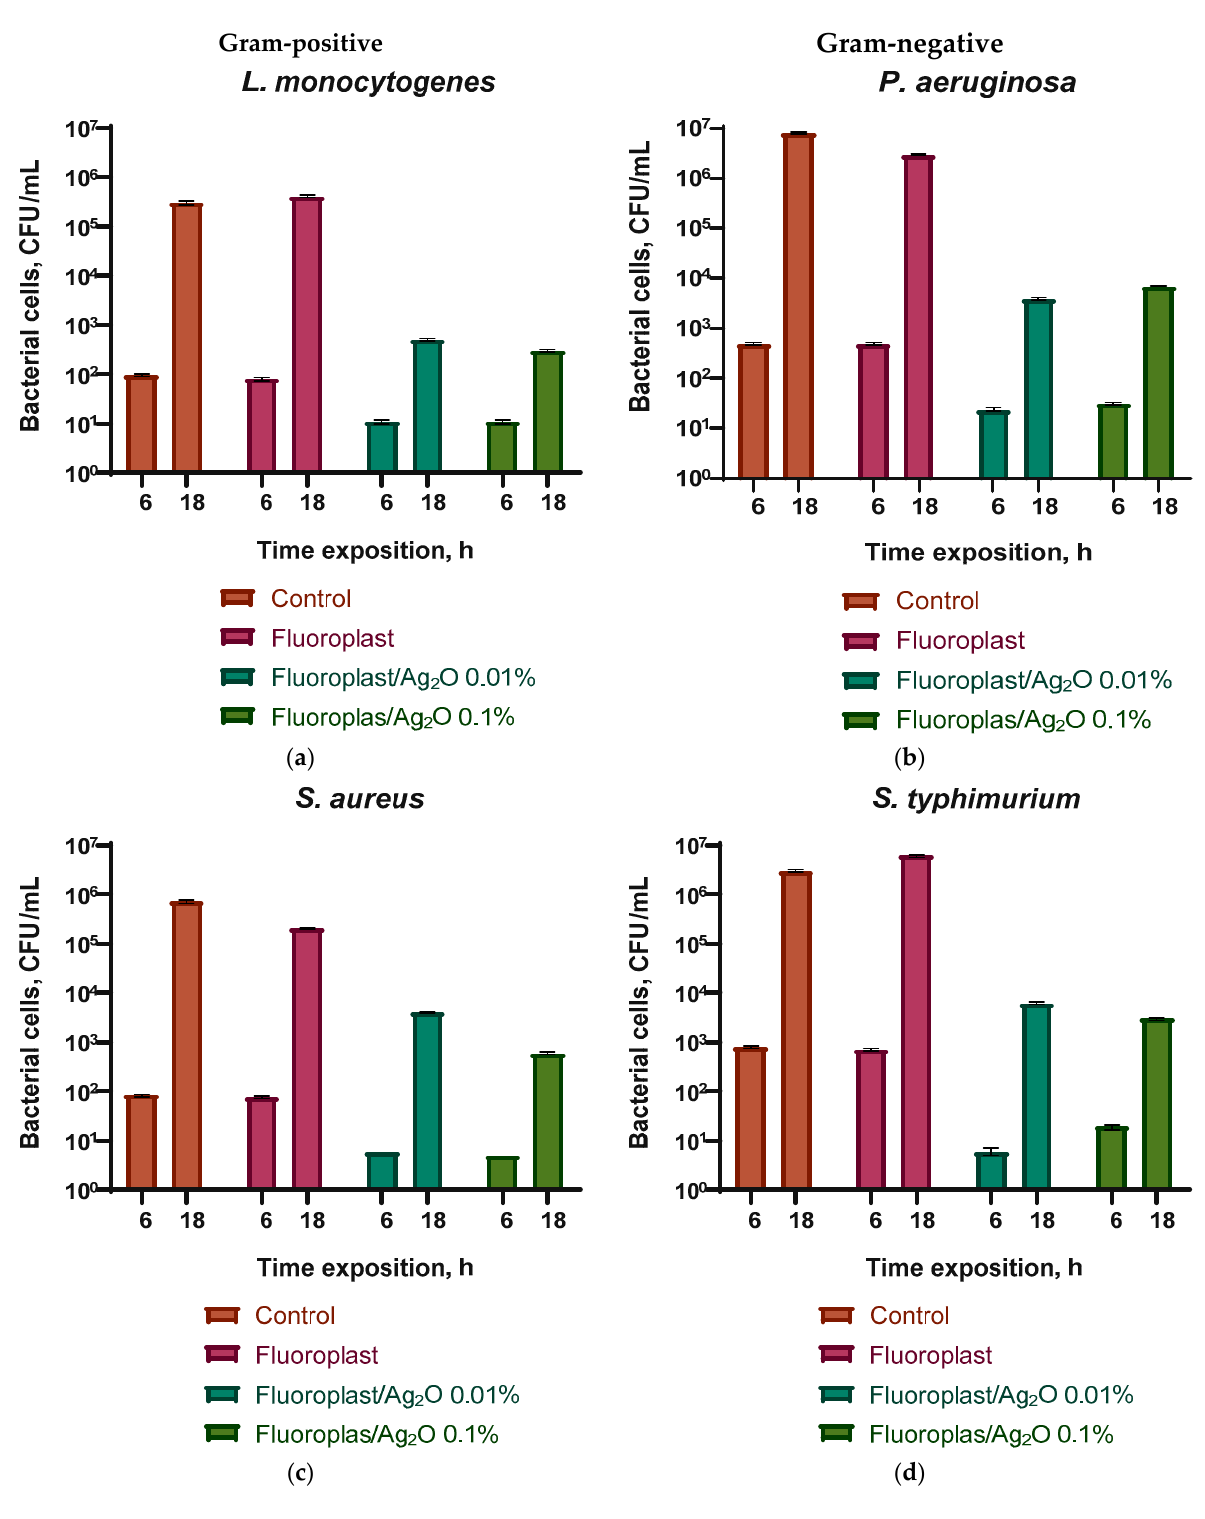
Figure 7. Evaluation of the bacteriostatic effect of a composite material based on fluoroplasts and Ag 2 O NPs against Gram-positive bacteria Listeria monocytogenes ( a ) and Staphylococcus aureus ( c ) and Gram-negative Pseudomonas aeruginosa ( b ) and Salmonella typhimurium ( d ) after 6 and 18 h of cultivation. Results are presented as mean ± SE ( n = 3).